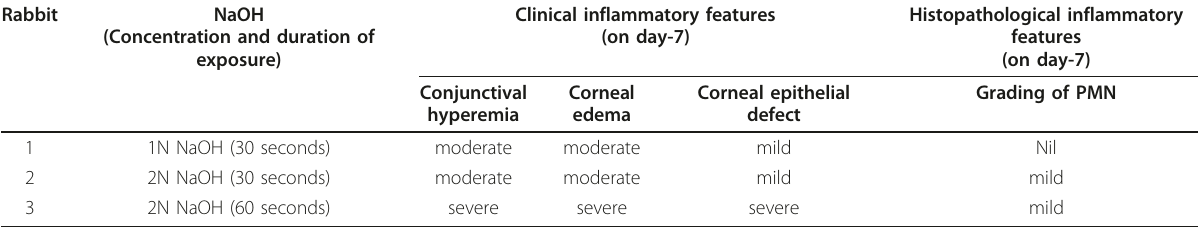
Table 2 Results of the preliminary study in alkali chemical injury on rabbit ’ s cornea Rabbit NaOH (Concentration and duration of